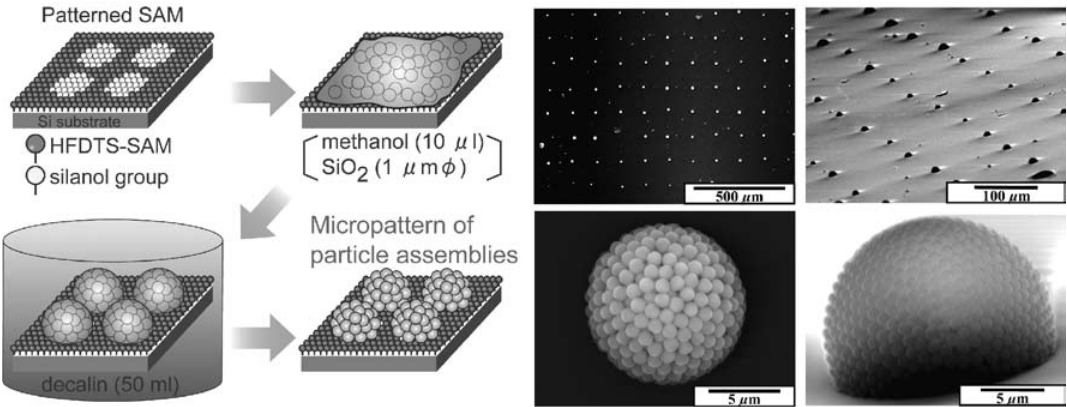
Fig. 7 Conceptual process and SEM micrographs of micropattern of spherical particle assemblies. Top left: Micropattern of spherical particle assemblies. Bottom left: Magnified area of top left. Top right: Tilted micropattern of spherical particle assemblies. Bottom right: Magni- fied area of top right.